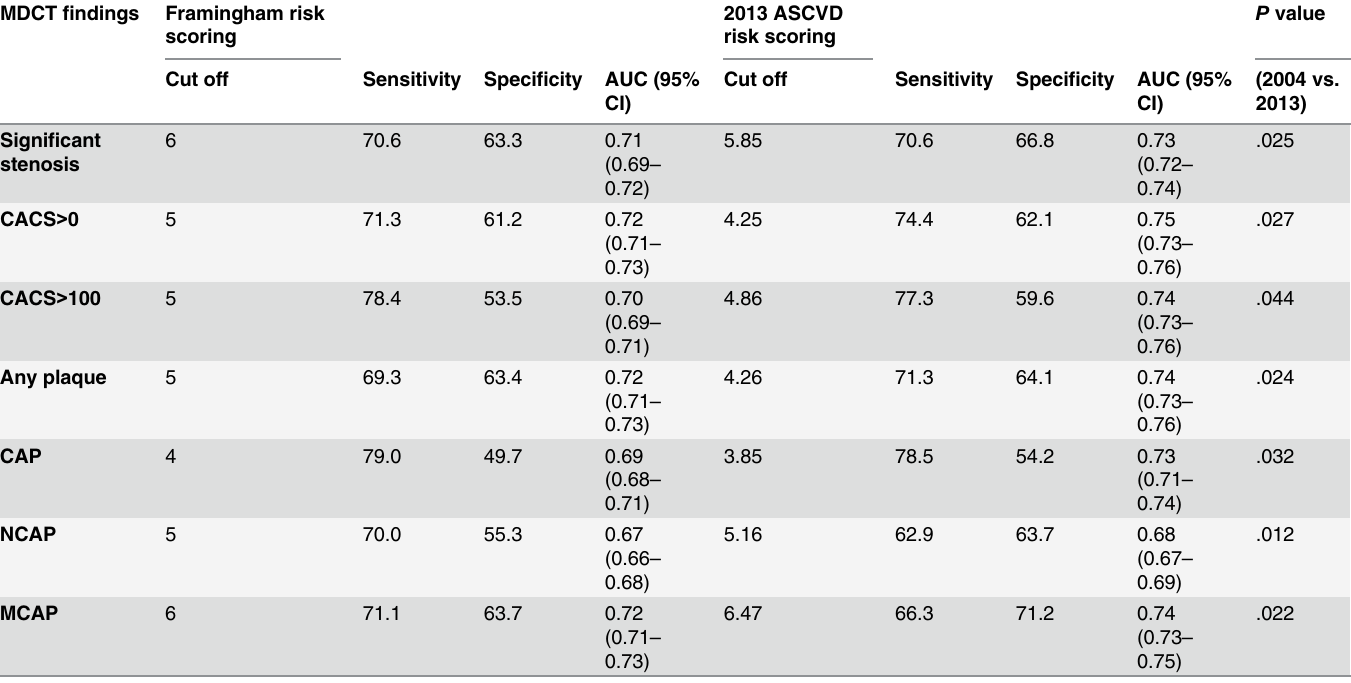
Table 4. Comparison of sensitivity and specificity between Framingham and 10-year ASCVD risk scoring system for alignment of statin therapy in subjects with subclinical coronary atherosclerosis. MDCT fi